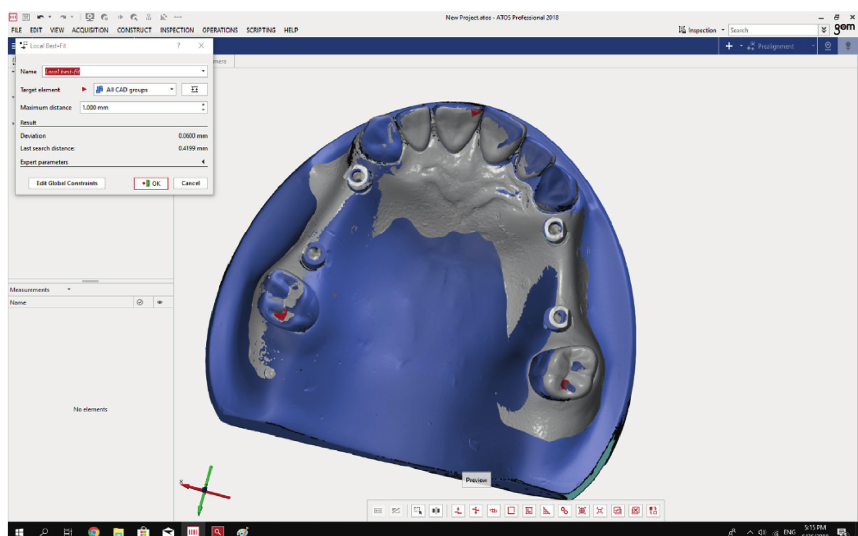
Figure 3: The local best-fit feature was selected from the menu in GOM Inspect.